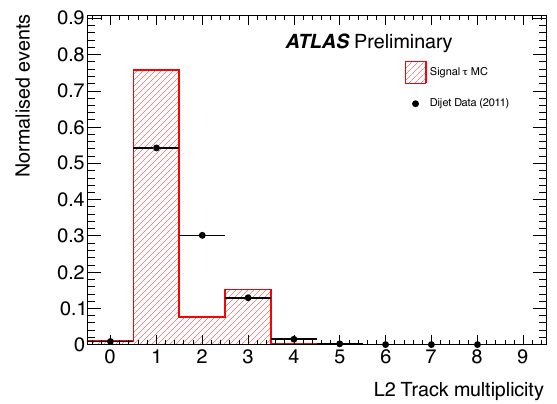
Fig. 3. Tau trigger e ffi ciency measured in Z → ττ decays us- ing 2011 data by applying a tag-and-probe method for the EF tau 20 medium item. The e ffi cieny is measured w.r.t. o ffl ine tau candidates passing medium identification requirements as a func- tion of the o ffl ine tau p T [2].